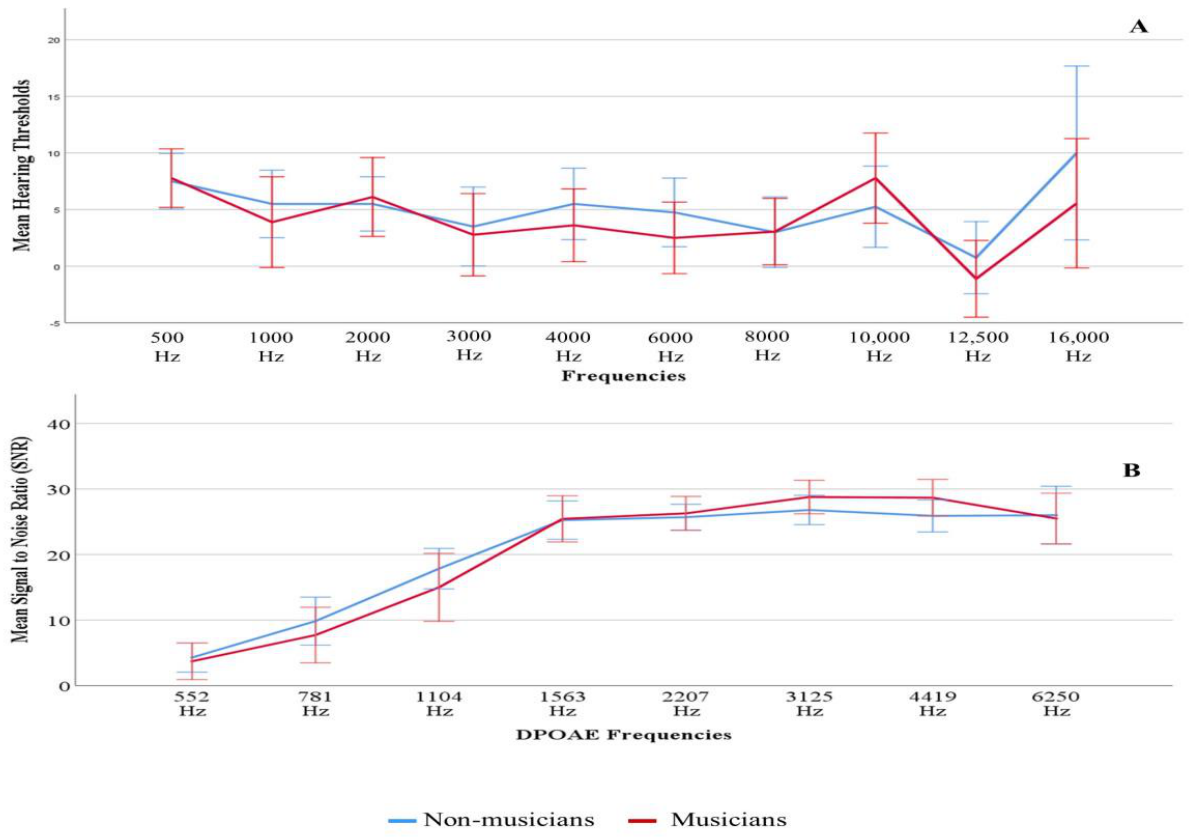
Figure 1. Mean hearing thresholds (Panel ( A )) and mean DPOAE SNRs (Panel ( B )) of left ear with standard error according to groups.